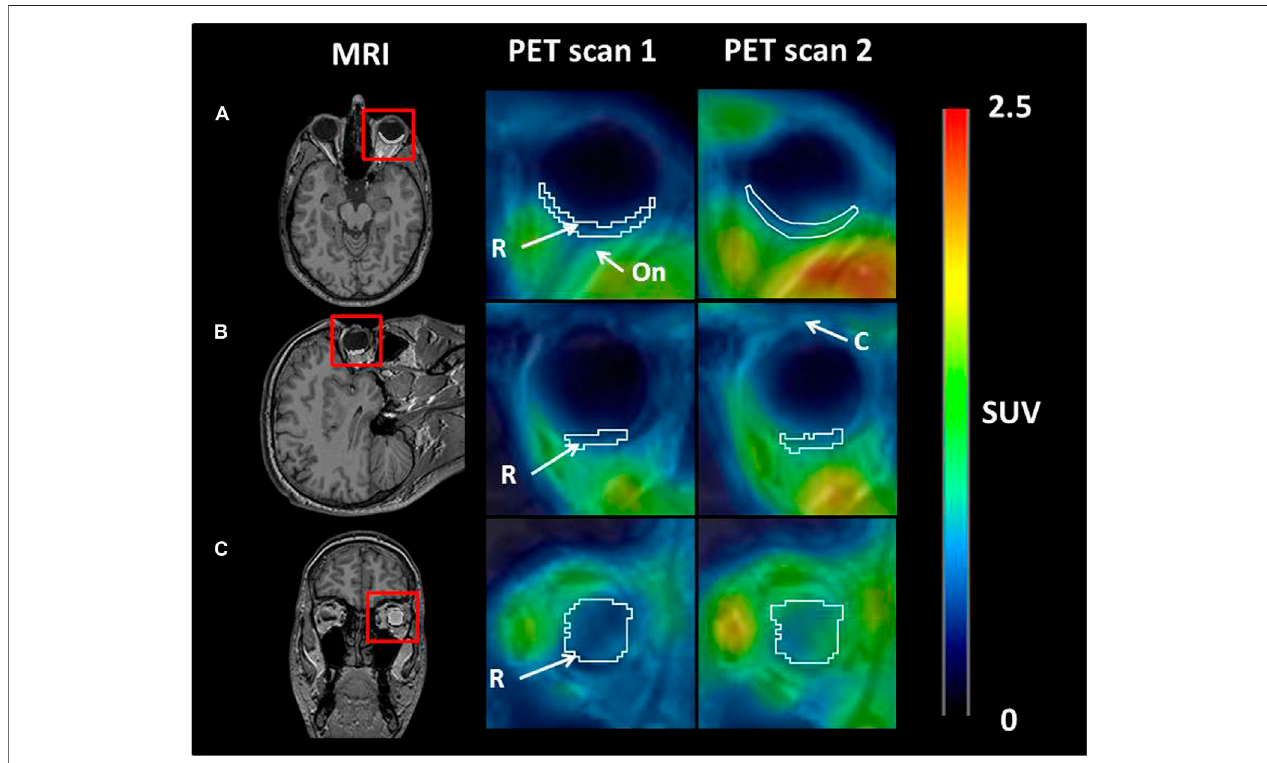
FIGURE1| Axial (A) ,sagittal (B) ,andcoronal (C) planesofrepresentativeMRandPETaverageimages(0 – 60 min)atbaseline(scan1)andduringABCB1inhibition (scan 2) in one c.421CA carrier. Red rectangles on MR images indicate magni fi ed area on PET images. A representative region of interest for retina (white contour) is shown. Anatomical structures are labelled with arrows: R, retina; On, optical nerve; C, cornea. Radiation scale is expressed as standardized uptake value (SUV) and set from 0 to